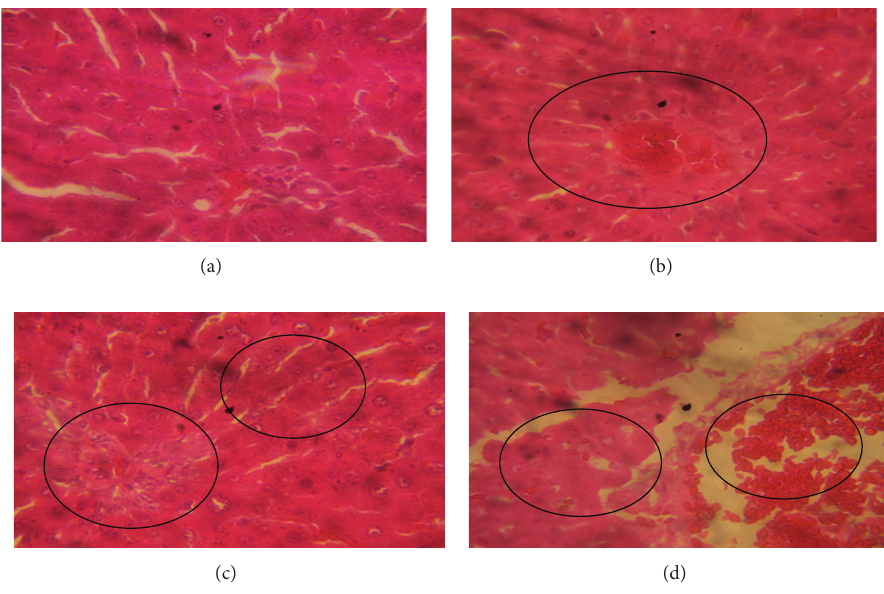
Figure 7: Photomicrographs of rat liver following oral and repeated exposure to Fijk herbal at different dosages. (a) Control group given distilled water showing intact cellular morphology; (b) group given Fijk herbal at 15 mg/kg body weight showing mild inflammation and hemorrhage; (c) group given Fijk herbal at 30 mg/kg body weight showing hyperemia and inflammation; (d) group given Fijk herbal at 45 mg/kg body weight showing hyperemia, ruptured vascular channels and hemorrhage, H&E staining ( × 400).